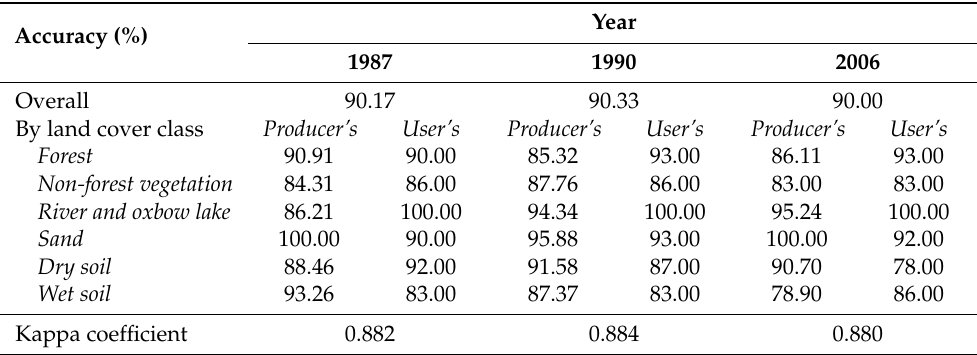
Table 1. Producer’s and user’s classification accuracies for the (hardened) fuzzy classified Landsat images acquired in 1987, 1990, and 2006, respectively.